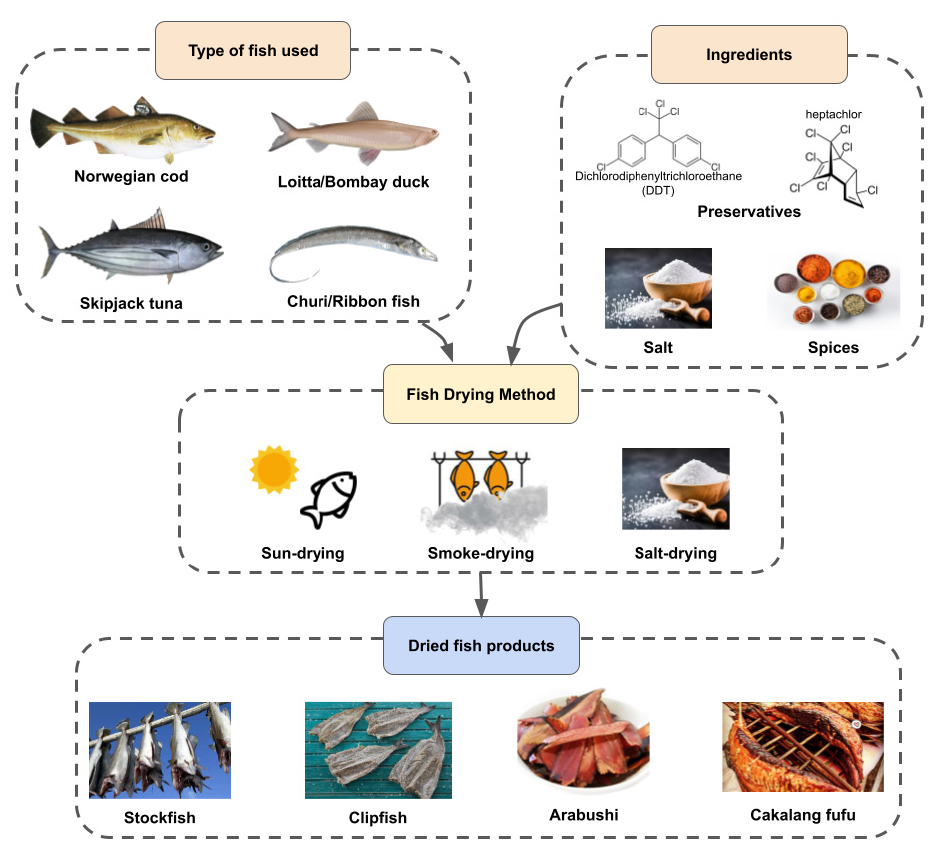
Figure 1. Summary of the types of dried fish, ingredients used and drying methods in a general process of fish drying .